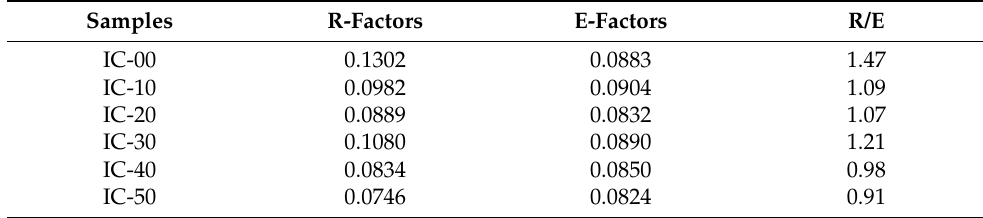
Table 3. Refinement factors and R/E values of the ceramic samples.